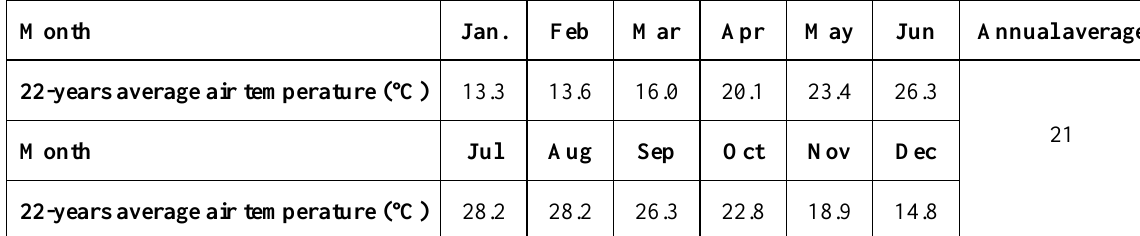
Table 4. Averaged air temperature/month for the suggested location